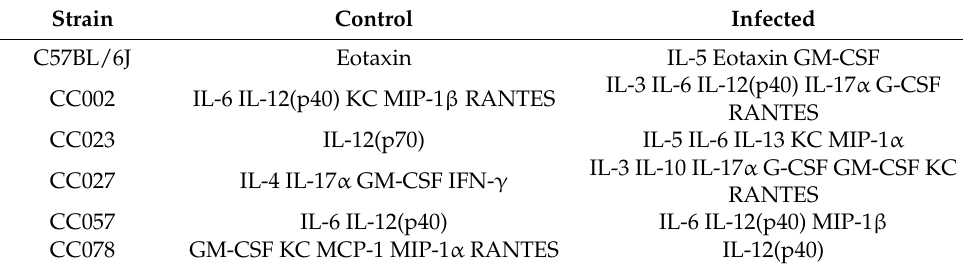
Table 3. Acute phase immune responses varied by strain and infection status. We identified strain- specific differences in immune response between 4 and 14 d.p.i. that were attributable to TMEV infection or, in the case of those observed in PBS-injected mice, inherent to the strain from the injection procedure. Cytokines and chemokines induced by the stress of the injection procedure itself were eliminated from consideration (Table 2) by normalizing post-injection levels to the strain-specific pre-injection (baseline)